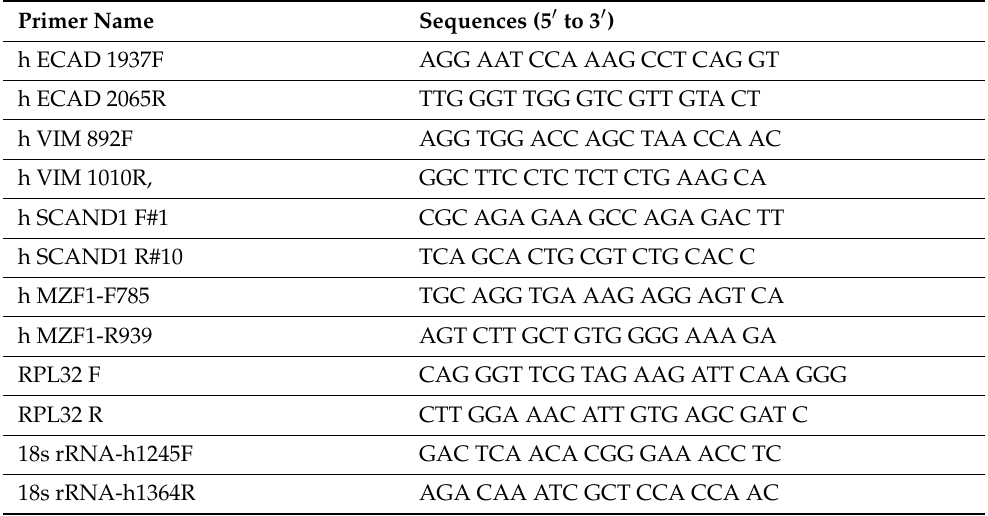
Table 1. Primer sequences for